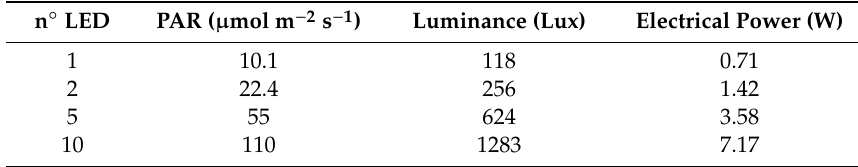
Table 1. Energy consumption (W), maximum values of illuminance (Lux) and photosynthetic active radiation (PAR, µmol m − 2 s − 1 ) in function of the number of LEDs.